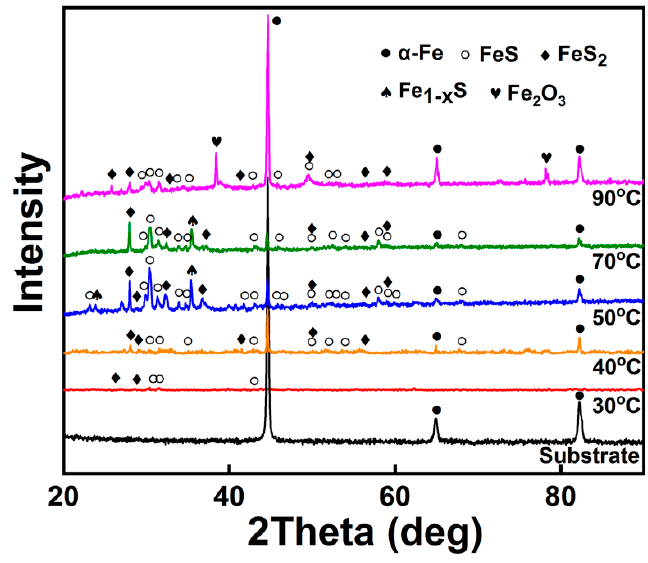
Figure 1. X-ray diffraction (XRD) patterns of the AISI 5140 steel before and after chemical bath Figure 1. X-ray di ff raction (XRD) patterns of the AISI 5140 steel before and after chemical bath deposition coating treatment at different temperatures. deposition coating treatment at di ff erent